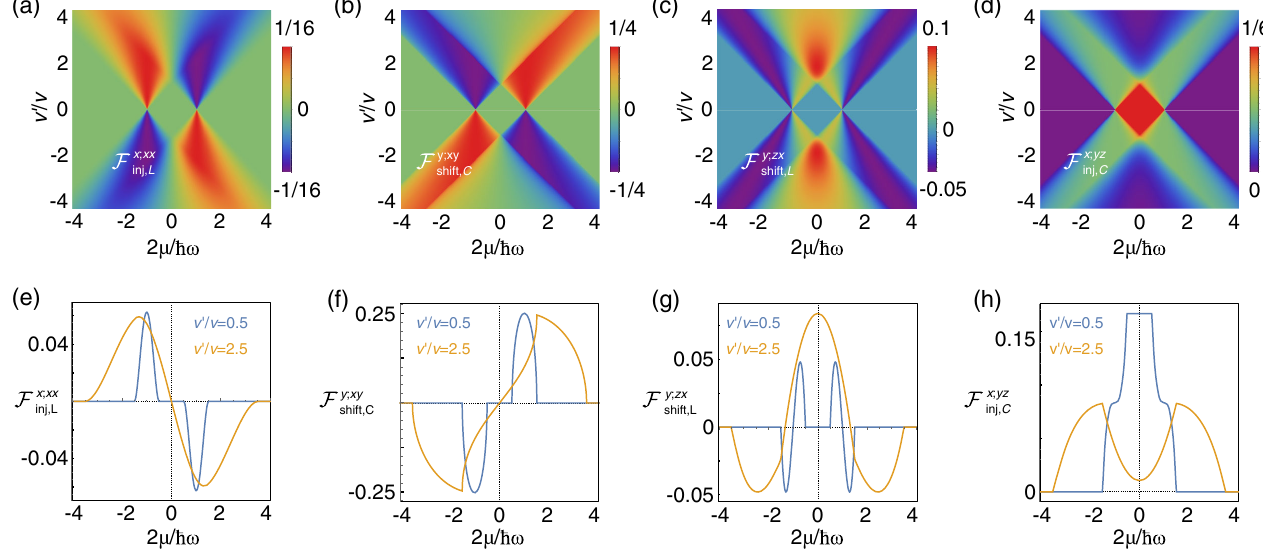
FIG. 2. F c ; ab of a tilted Weyl point in three dimensions. (a,e) x ; xx component of the linear injection. (b,f) y ; xy component of the circular shift. (c,g) y ; zx component of the linear shift. (d,h) x ; yz component of the circular injection. Since we take ω > 0 , the sign of 2 μ = ℏ ω here should be understood as the sign of the chemical potential μ